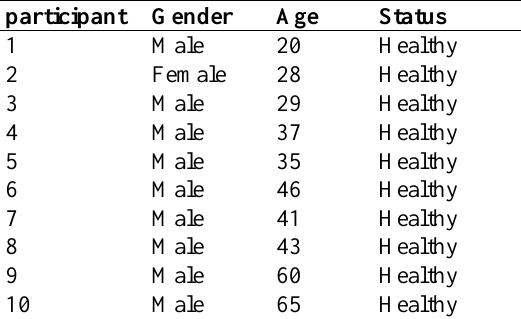
Table 1, The volunteers’ information.